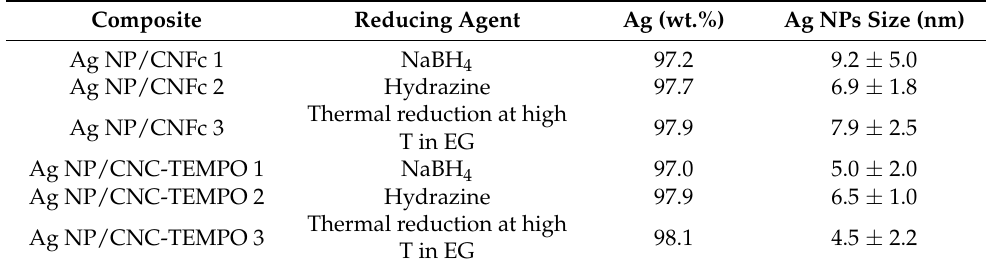
Table 2. Summary of all synthesized Ag NP/NC composites.